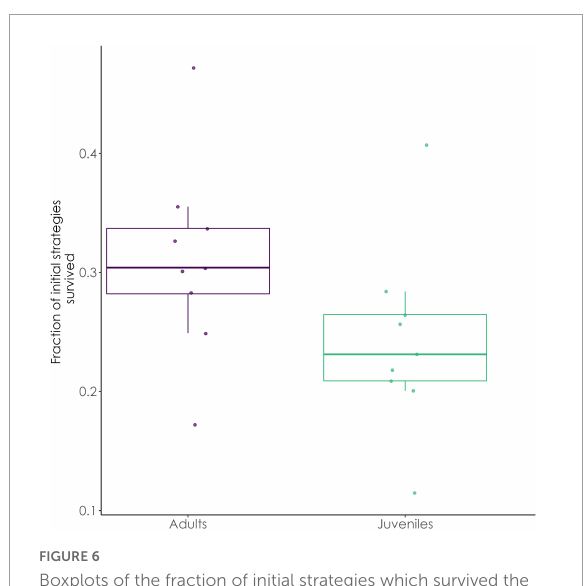
FIGURE6 Boxplots of the fraction of initial strategies which survived the simulation, adult (Left) vs. juvenile thalli (Right). The boxplots contain 9 values each, corresponding to the different regions of Italy analyzed here. Colored bars represent the density of values.